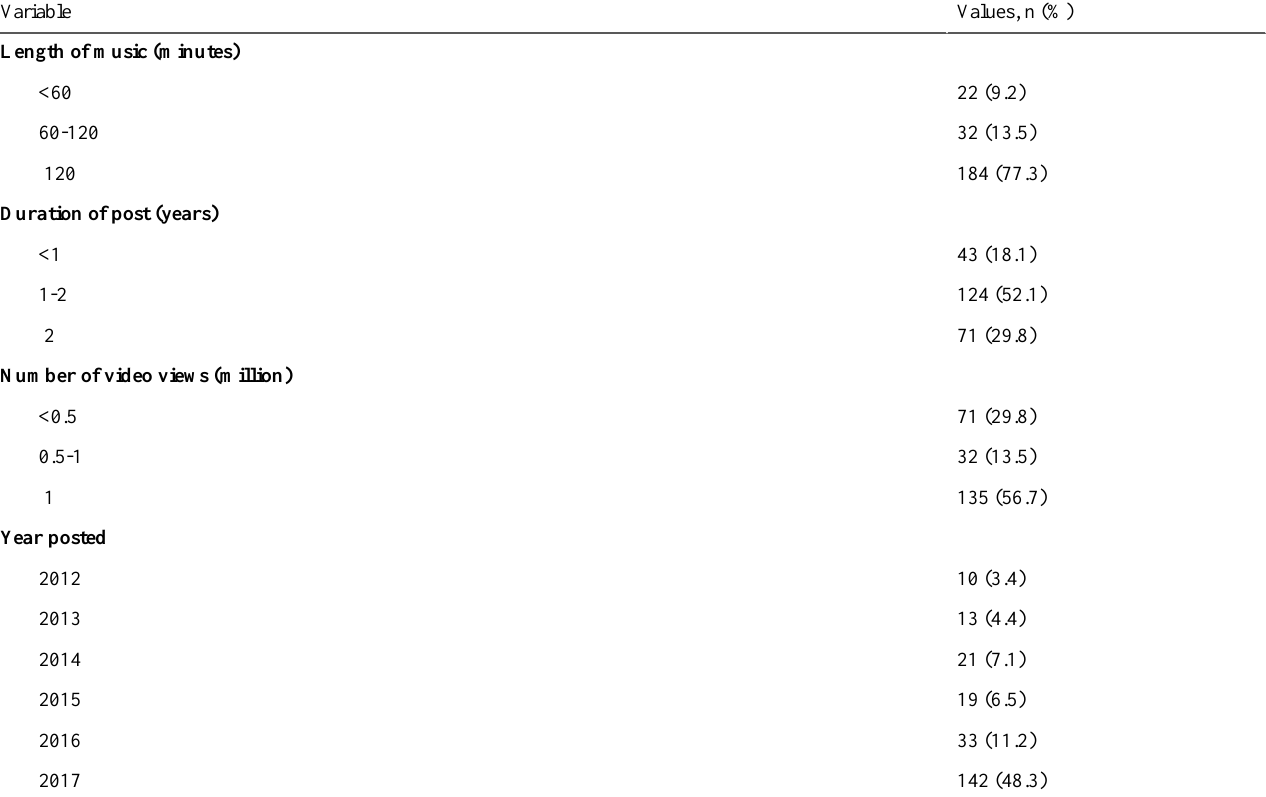
Table 1. Summary of sleep-aiding YouTube music videos included in the study analysis